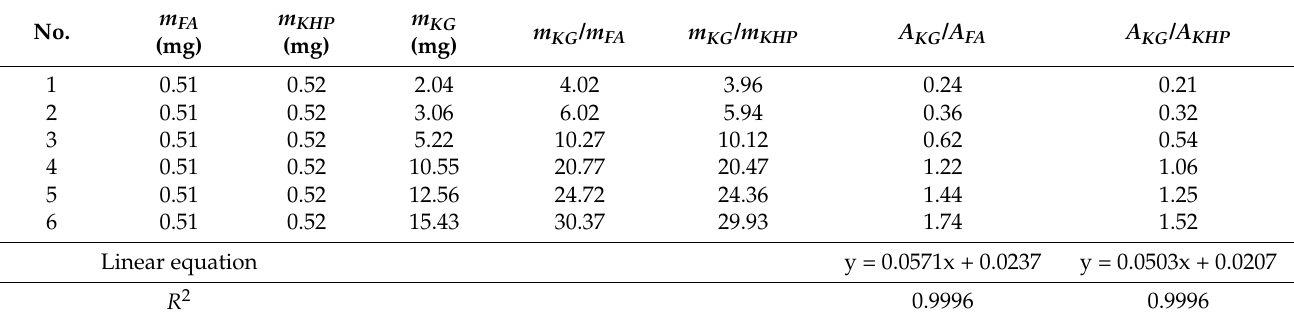
Table 1. Linearity and range of dipotassium glycyrrhizinate by qNMR.